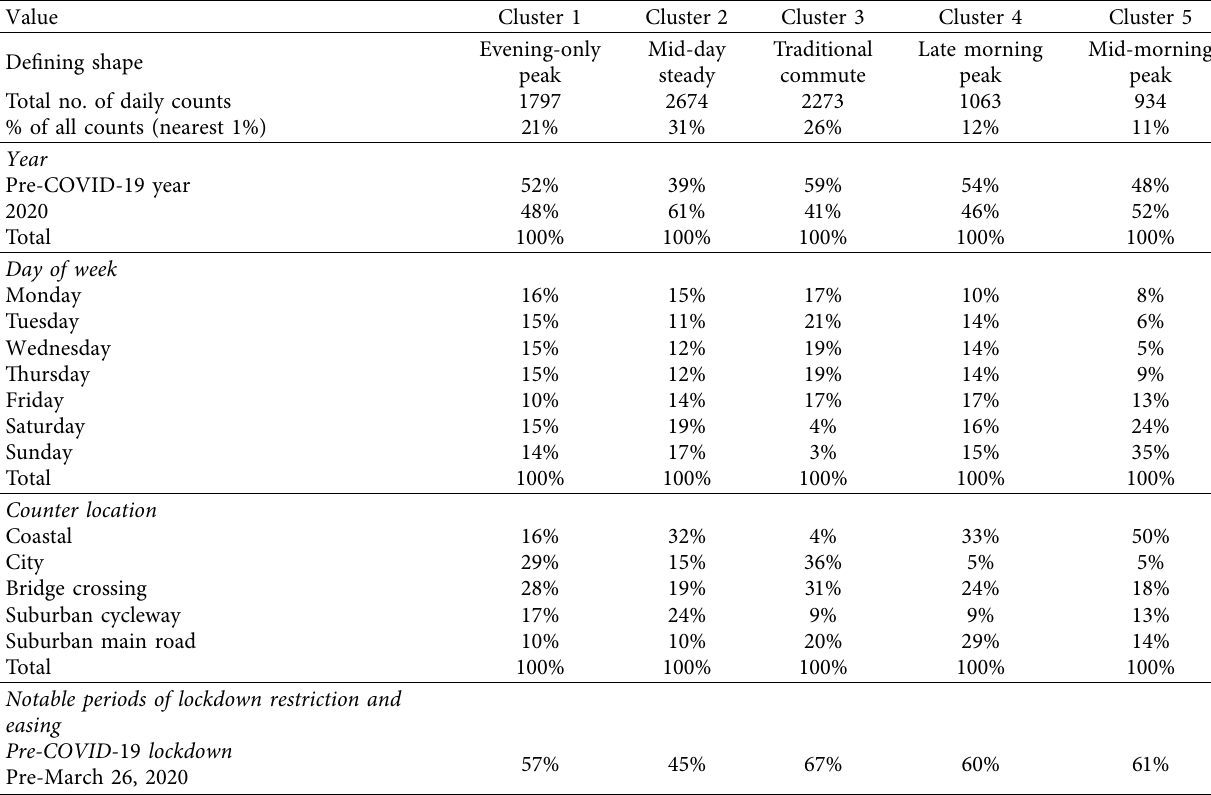
Table 2: Overview of the characteristics of each cluster.